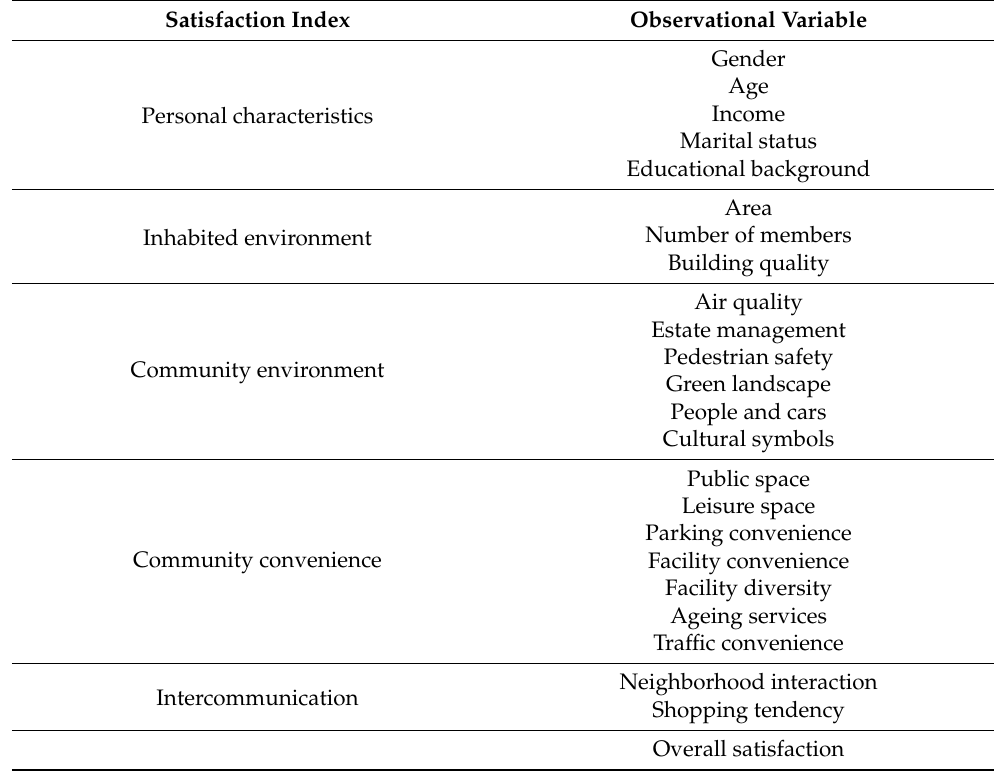
Table 3. Questionnaire structure and